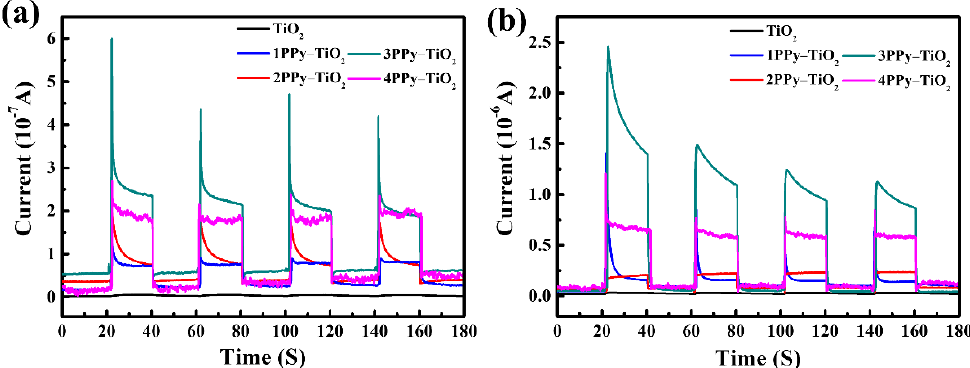
Figure 6. I-t curves of FTO-TiO 2 -FTO and FTO-nPPy-TiO 2 -FTO devices prepared by different deposition times with 254 nm (( a ) , 500 μW/cm 2 ) and 365 nm (( b ) , 470 μW/cm 2 ) UV light illumination.